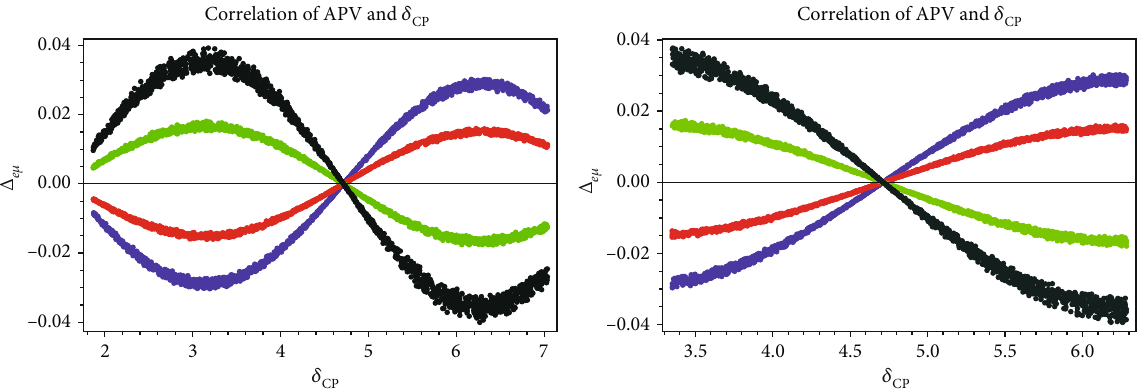
Figure 8: The correlation between the apparent P violation (APV) with di ff erent amplitudes. The conventions of the mixing parameters are the same as those in Figure 6. The blue scatter points are for the case Δ s 2 12 = 0 : 2 , the red points for the case Δ s 2 12 = 0 : 1 , the green points for the case Δ s 2 12 = − 0 : 1 , and the black points for the case Δ s 2 12 = − 0 : 2 . (a) is for the case of the normal mass ordering. (b) is for the case of the inverted mass